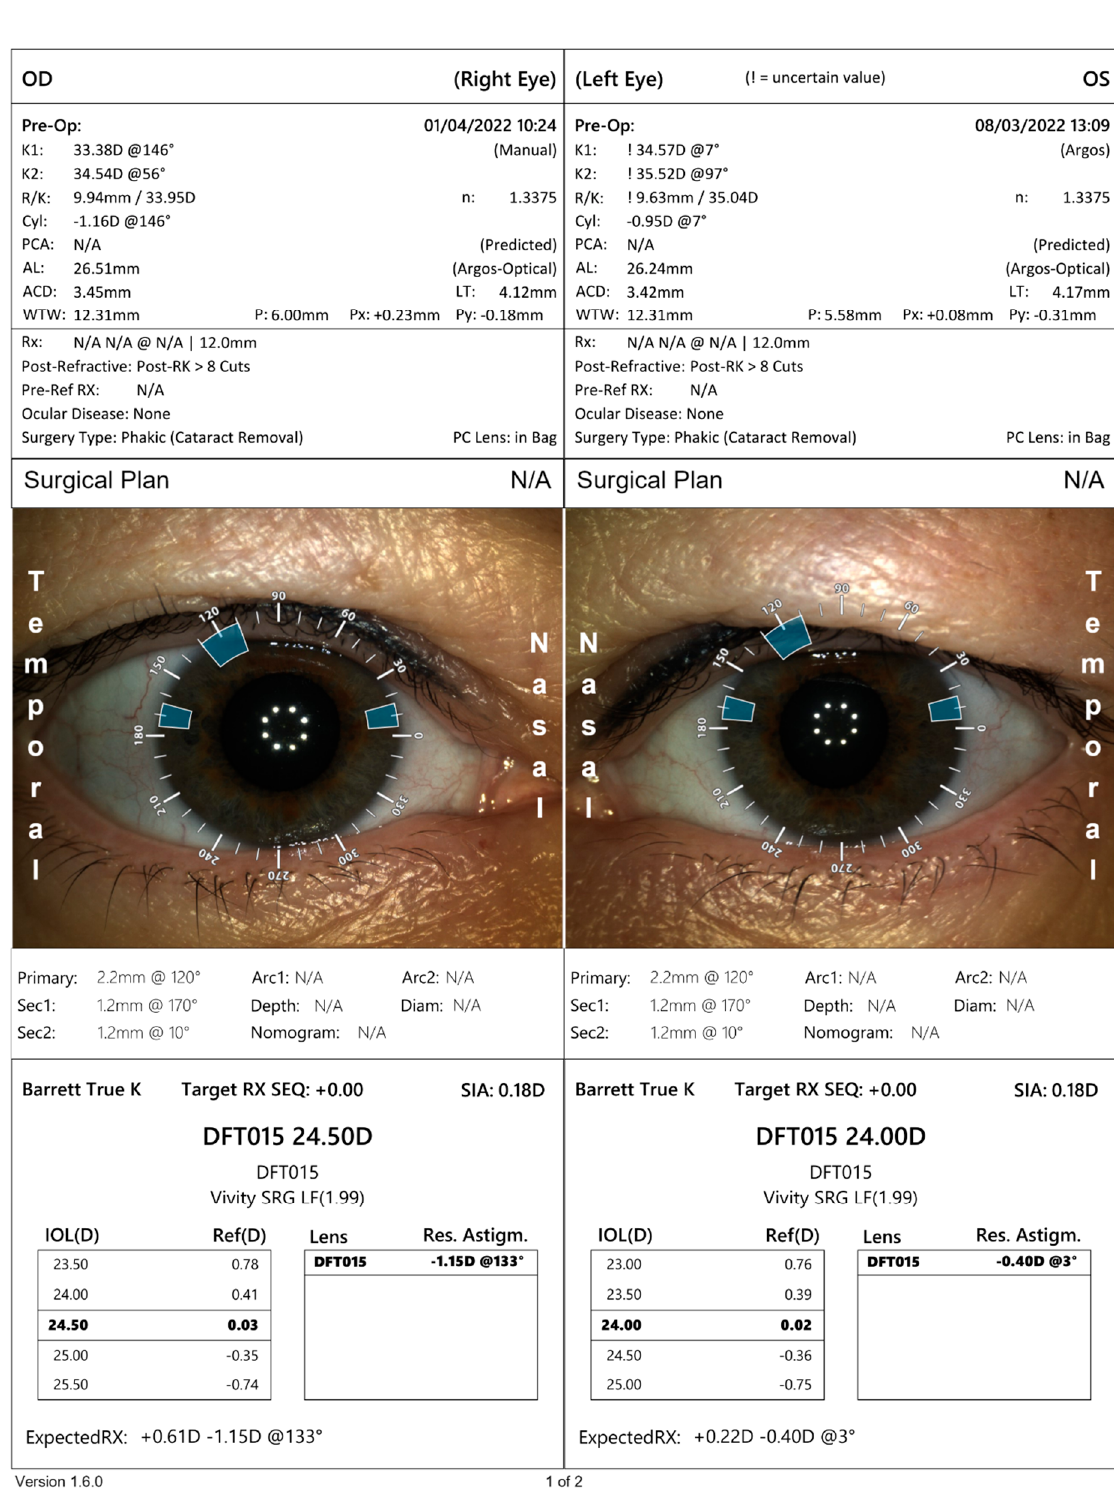
Figure 4. Result of intraocular lens power calculation using the Argos biometer.